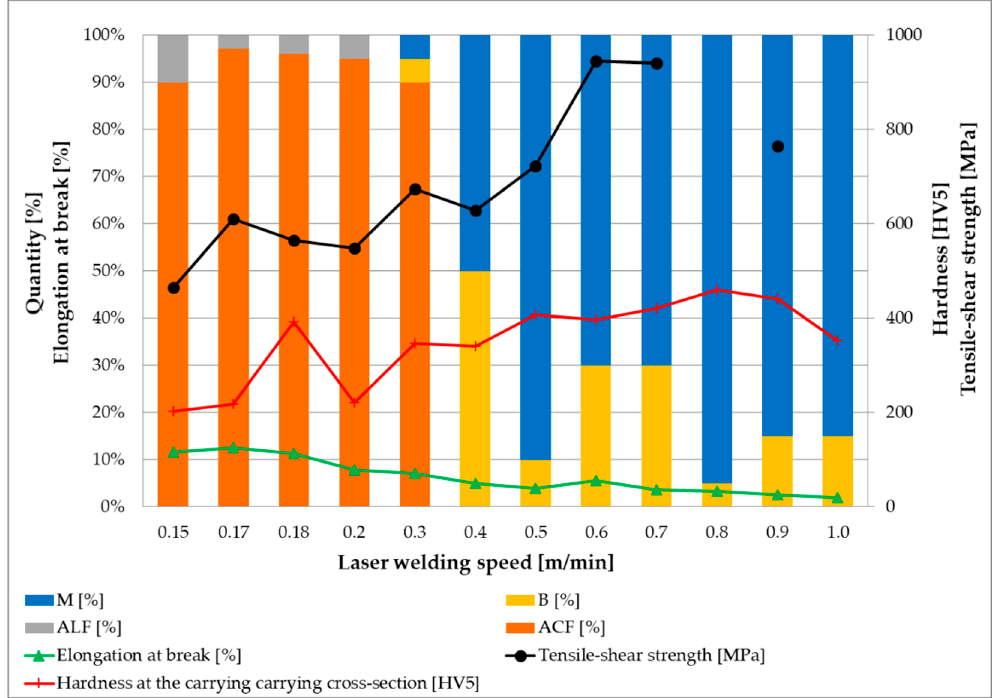
Figure 11. The effect of welding speed on the microstructure and hardness of the carrying part of the weld.